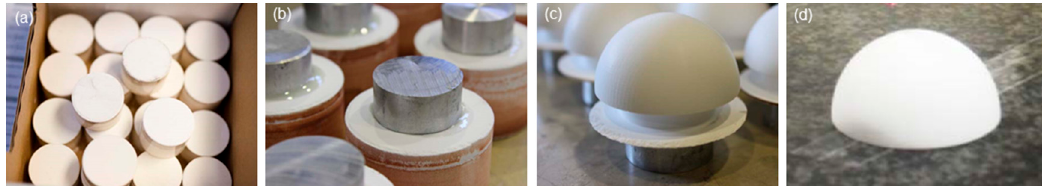
Figure 1. Raw material different stages of transformation during the manufacturing of the cup samples: ( a ) brown cylinders, ( b ) green cylinders fixed to the aluminum support discs, ( c ) green hemispheres before cross-cutting, and ( d ) sintered cups.